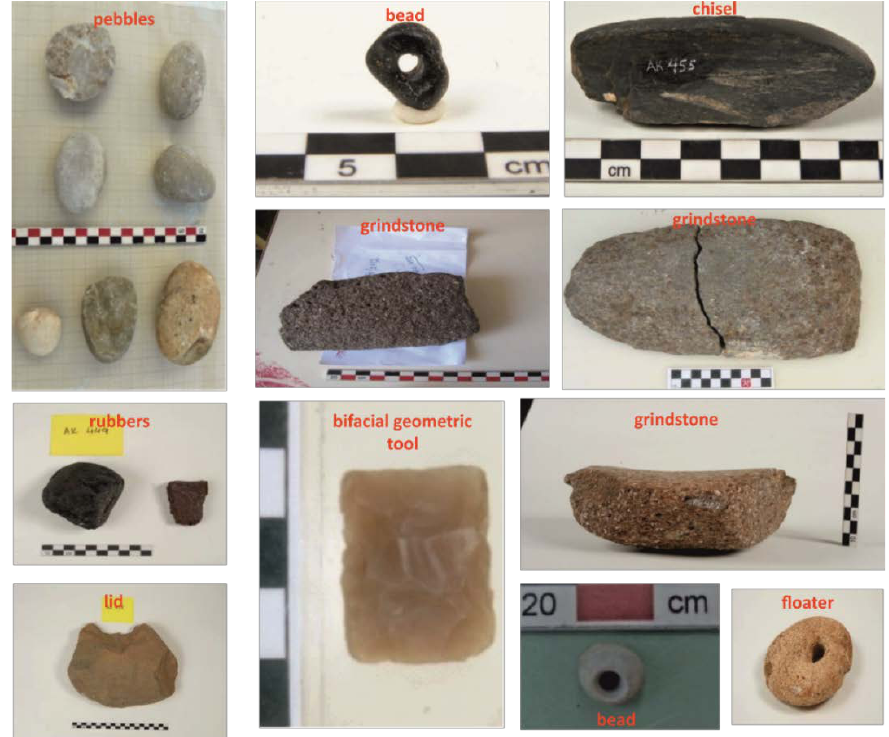
Figure 2. Representative photographs of the stone artefacts analyzed in the present study.